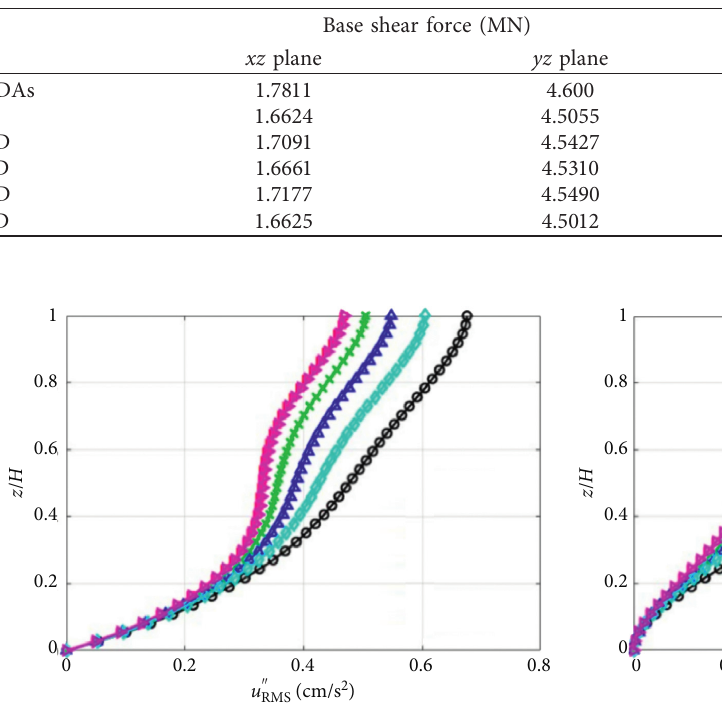
Figure 16: Along-wind peak displacements of the building. (a) xz plane. (b) yz plane. Table 20: Along-wind peak values for the internal forces at the base.